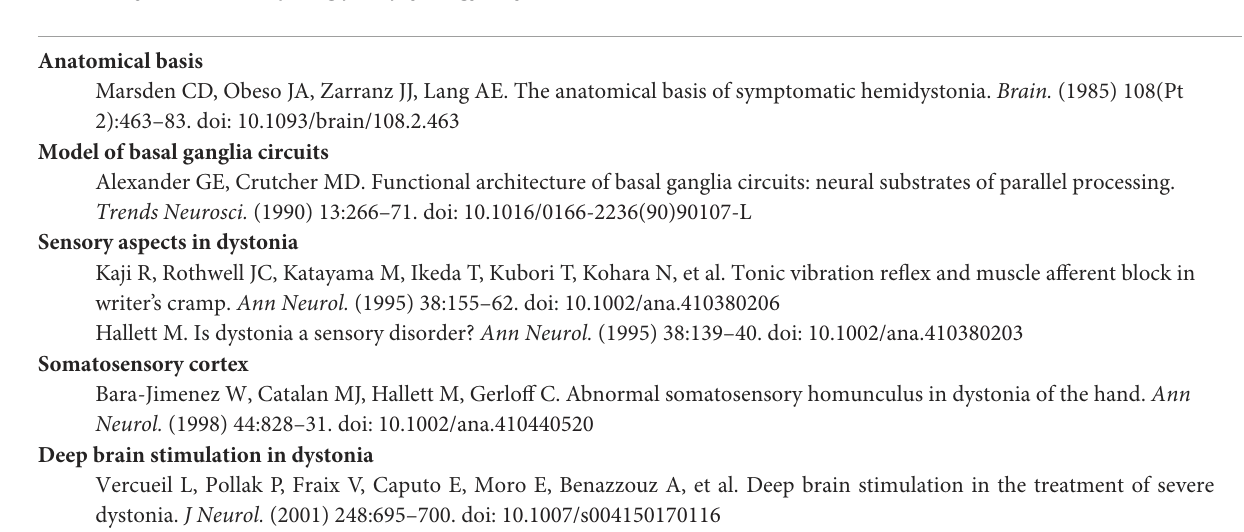
TABLE 1 Key references in exploring pathophysiology of